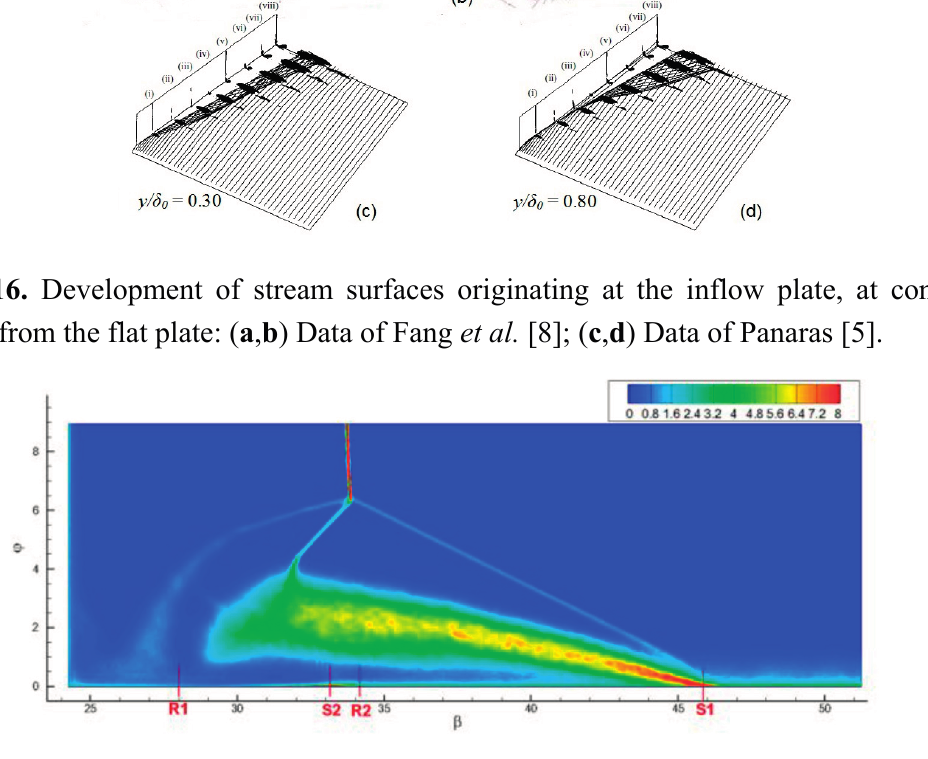
Figure 17. Turbulent kinetic energy (TKE) on the section at R = 226.3 mm, normalized with the square of the wall friction velocity at the inlet. Reprinted [8] with permission from the